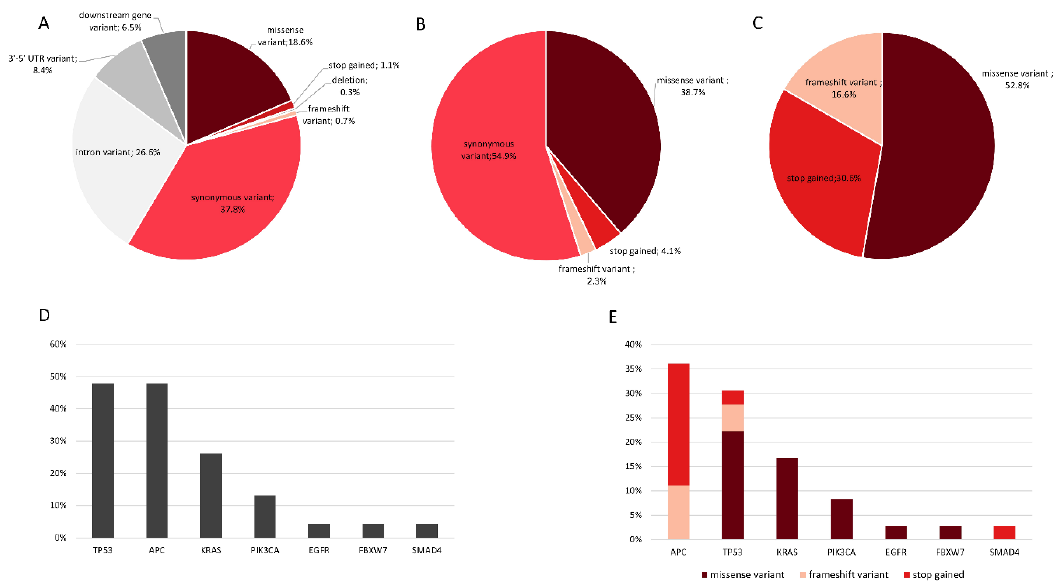
Figure 7. Mutational Profile of 44 tumors and mucosa tissues from 22 PSRT patients: ( A ) distribution of 958 genetic alterations according with position and functional effects; ( B ) distribution of 266 coding region variants according with predicted functional effects; ( C ) distribution of 36 tumor-associated somatic mutations according with predicted functional effects; ( D ) frequency distribution of somatic mutated genes in analysed patients; ( E ) frequency distribution of somatic variants with different functional effect in mutated genes.